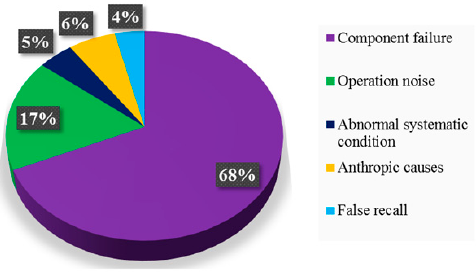
Figure 8. The statistics of failure-recall reasons.